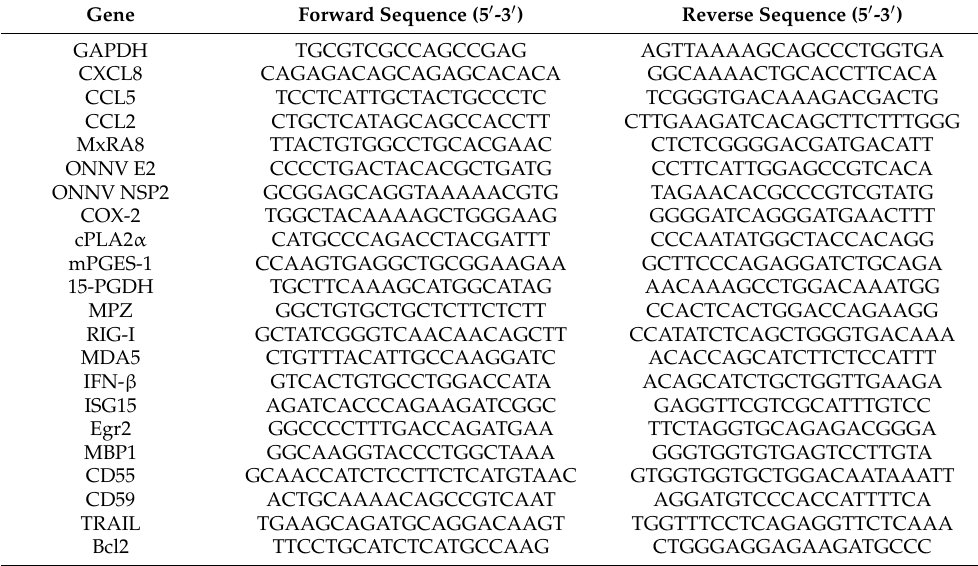
Table 1. List of primers used for